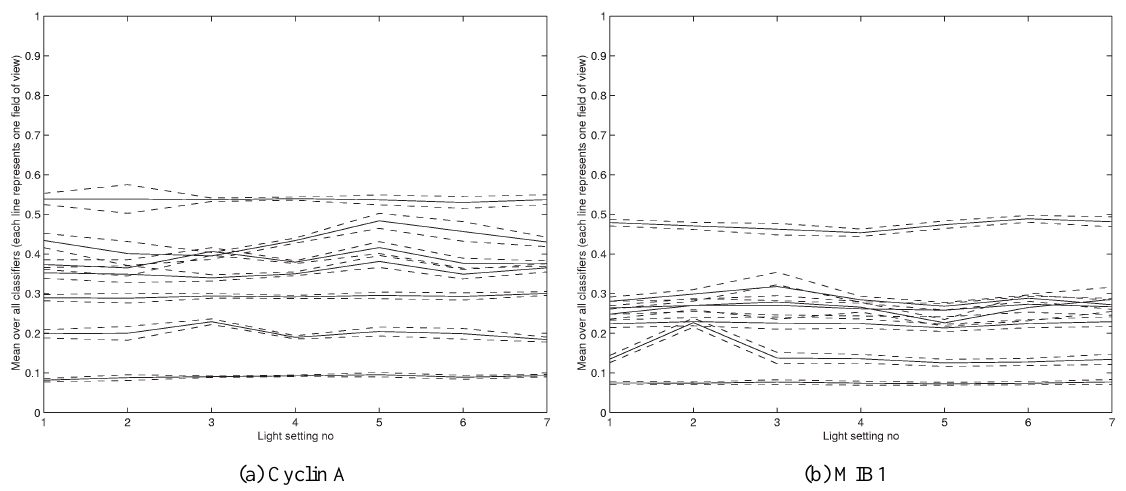
Fig. 10. Each line shows the mean and the dashed lines shows the 95% confidence interval for each field of view for each light setting, i.e., for each group of 7 controls applied to the same field of view in Fig. 9. This shows how the result varies due to changes in light settings.